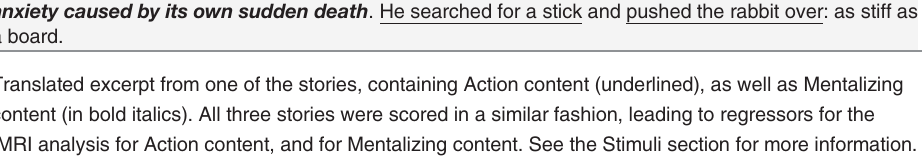
Table 1. Example of stimulus